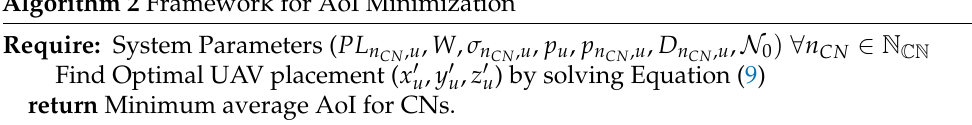
Algorithm 2 Framework for AoI Minimization